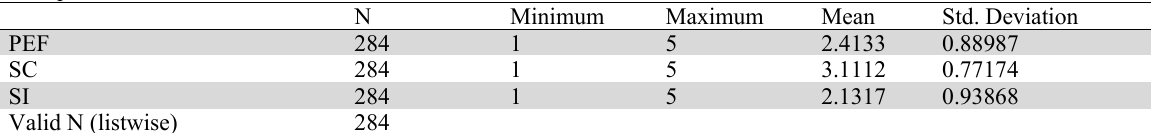
Descriptive statistics for latent